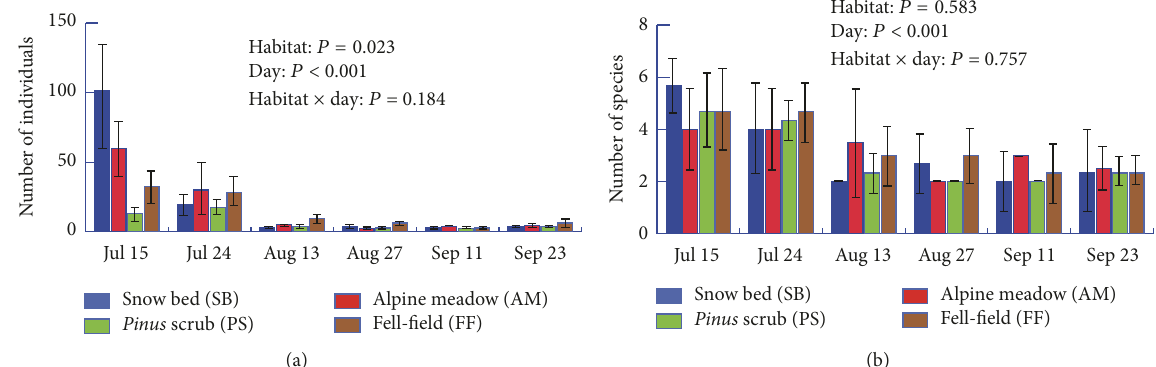
Figure 3: Total abundance (a) and species richness (b) of carabid beetles in the four habitats of the alpine-subalpine zone on Mt. Hakusan. 𝑃 values for the effects of habitat, day, and habitat × day interaction are based on negative binomial (for total abundance) and Poisson (for species richness) generalized linear models (GLMs). Data are presented as means ±